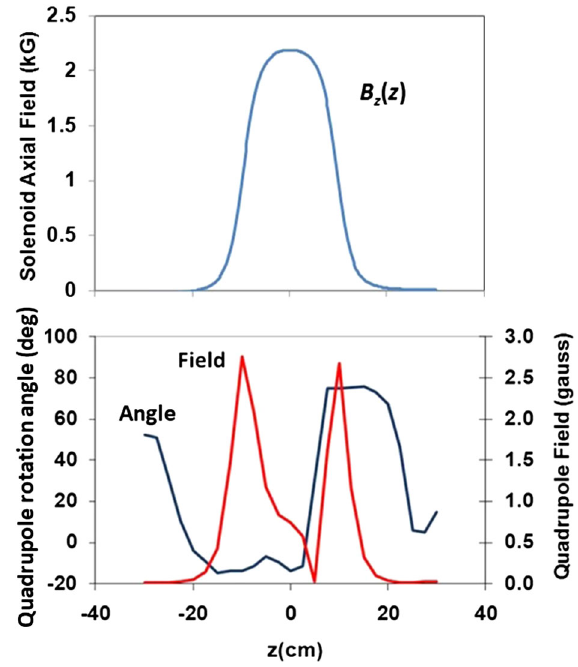
FIG. 2. Magnetic measurements of the LCLS gun solenoid for an integrated field of 0.046 T-m. Top: Hall probe measurements of the solenoid axial field. The transverse location of the measurement axis (the z axis) was determined by minimizing the radial field. Bottom: Rotating coil measurements of the quadrupole field. The rotating coil dimensions were 2.5 cm long with a 2.8 cm radius. The measured quadrupole field is thus averaged over these